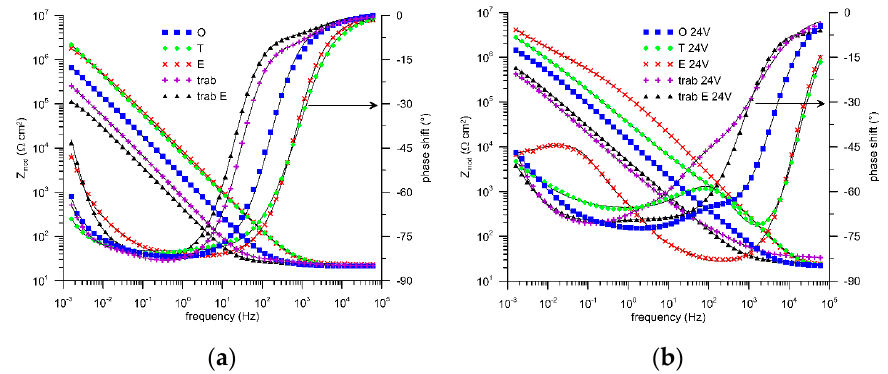
Figure 4. The electrochemical impedance spectra of specimens after 12 h in physiological solution (symbols—data, line—fit): ( a ) surfaces without anodization, ( b ) anodized surfaces.